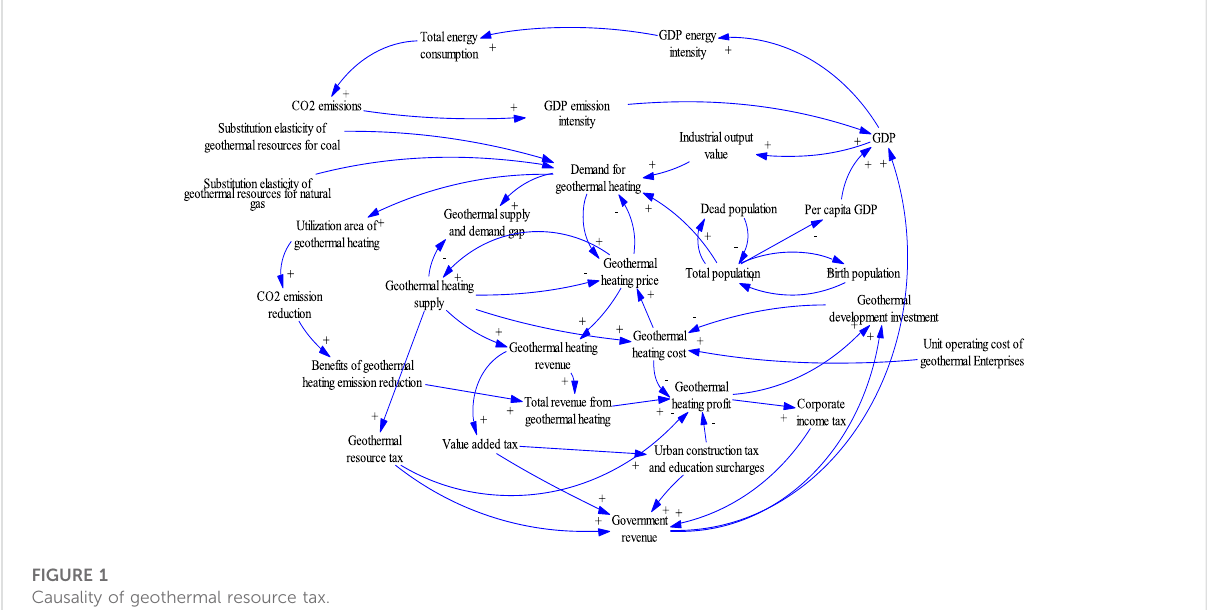
FIGURE 1 Causality of geothermal resource